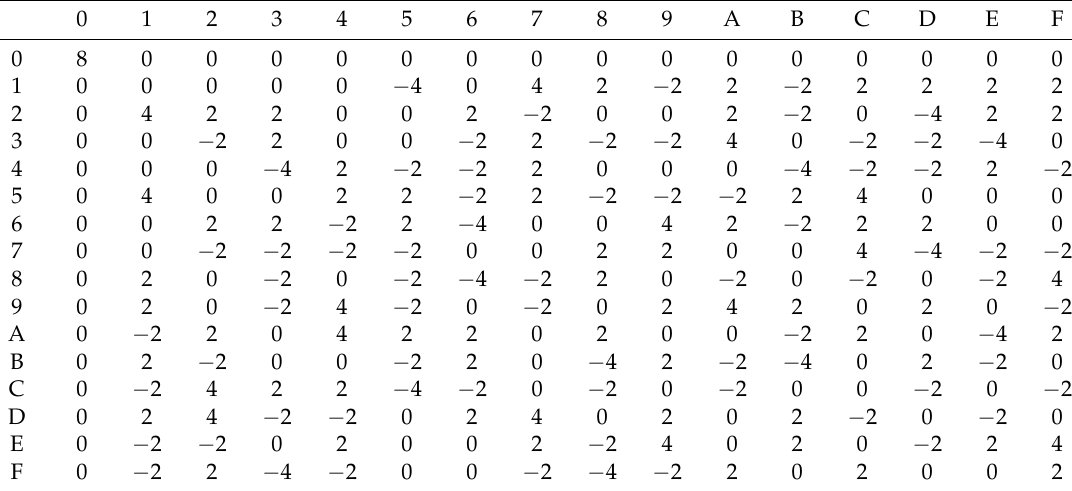
Table 5. Linear approximation table of the proposed